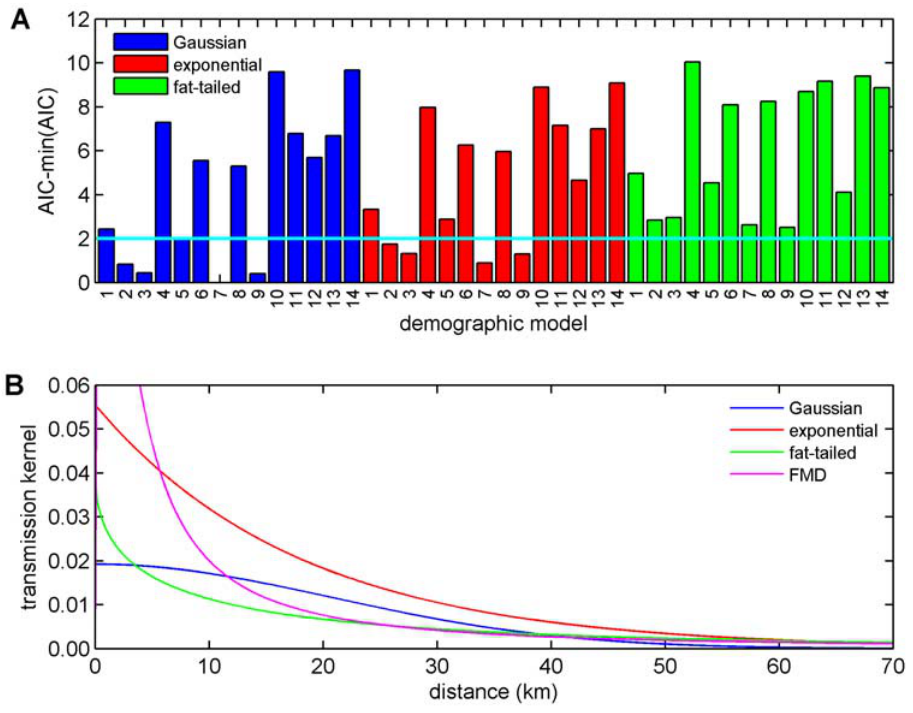
Figure 2. Models for the probability of transmission between farms. (A) Comparison of model fit for different transmission kernels and demographic models (defined in Table 3) based on the Akaike information criterion (AIC). The cyan line indicates a difference of two in AIC between a model and that with the lowest AIC (i.e. Gaussian kernel and demographic model presented in Table 4), taken to represent a significant difference in model fit. (B) Transmission kernels, (8), using the maximum-likelihood estimates obtained by fitting the models to outbreak data from northern Europe in 2006 (Table 4). The FMD kernel is that estimated by Chis Ster and Ferguson [24] from the outbreak of foot-and-mouth disease (FMD) in the UK during 2001.